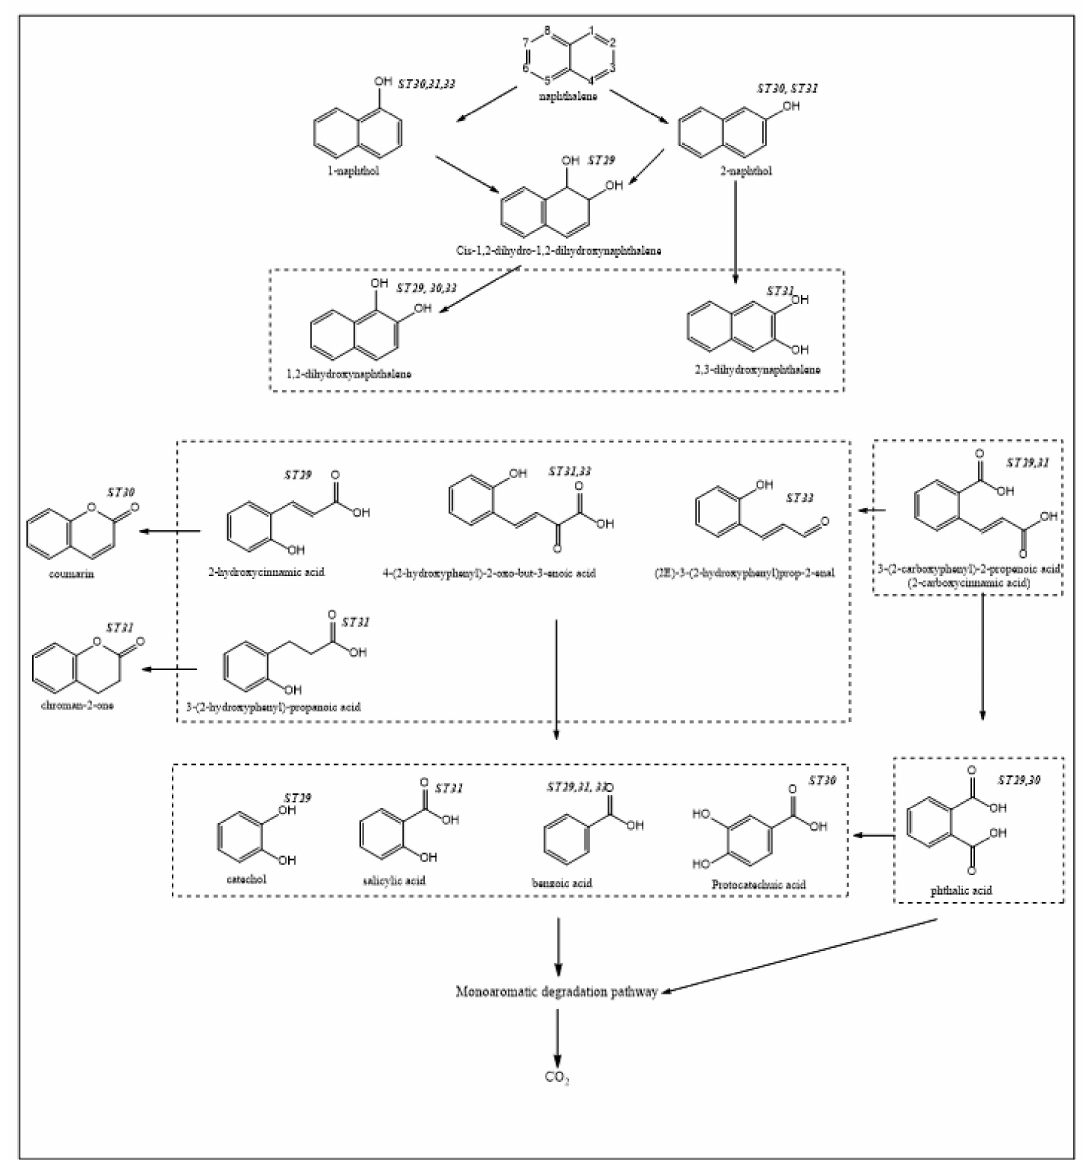
Figure 4. Possible pathways of naphthalene (NAPH) degradation by thermophilic